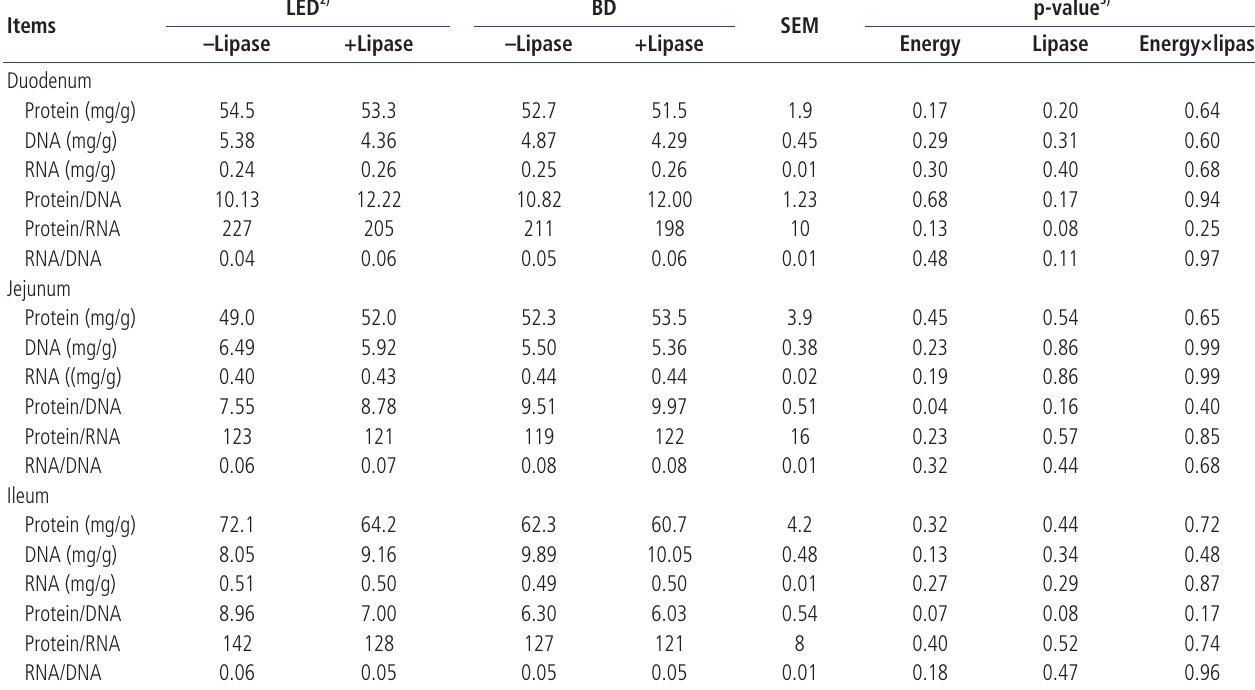
Table 7. Effects of dietary energy and lipase levels on the biochemical index of intestinal development in weaning pigs 1)